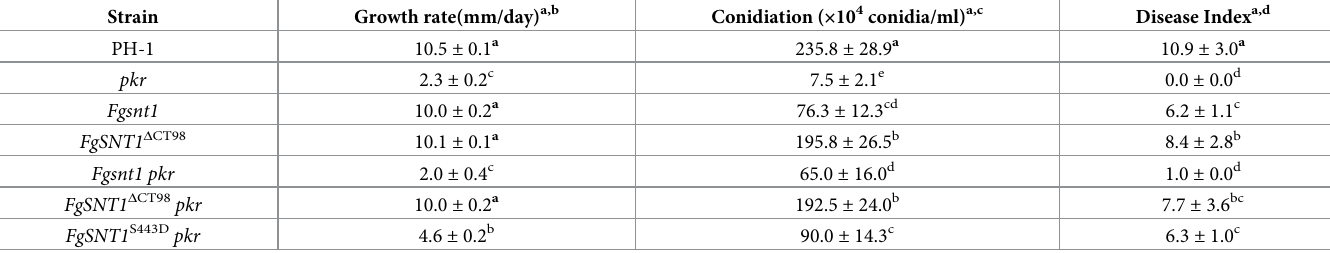
43% and 23% reduction in virulence. These results indicate that FgSNT1 is important for coni- diation and plant infection. Because deletion of CT98 had much less effects on conidiation and virulence than deletion of the entire gene, the C-terminal region of FgSnt1 likely has a minor Table 3. Phenotypes of the Fgsnt1 mutant and its transformant strains in growth, conidiation, and plant infection. Strain Growth rate(mm/day)